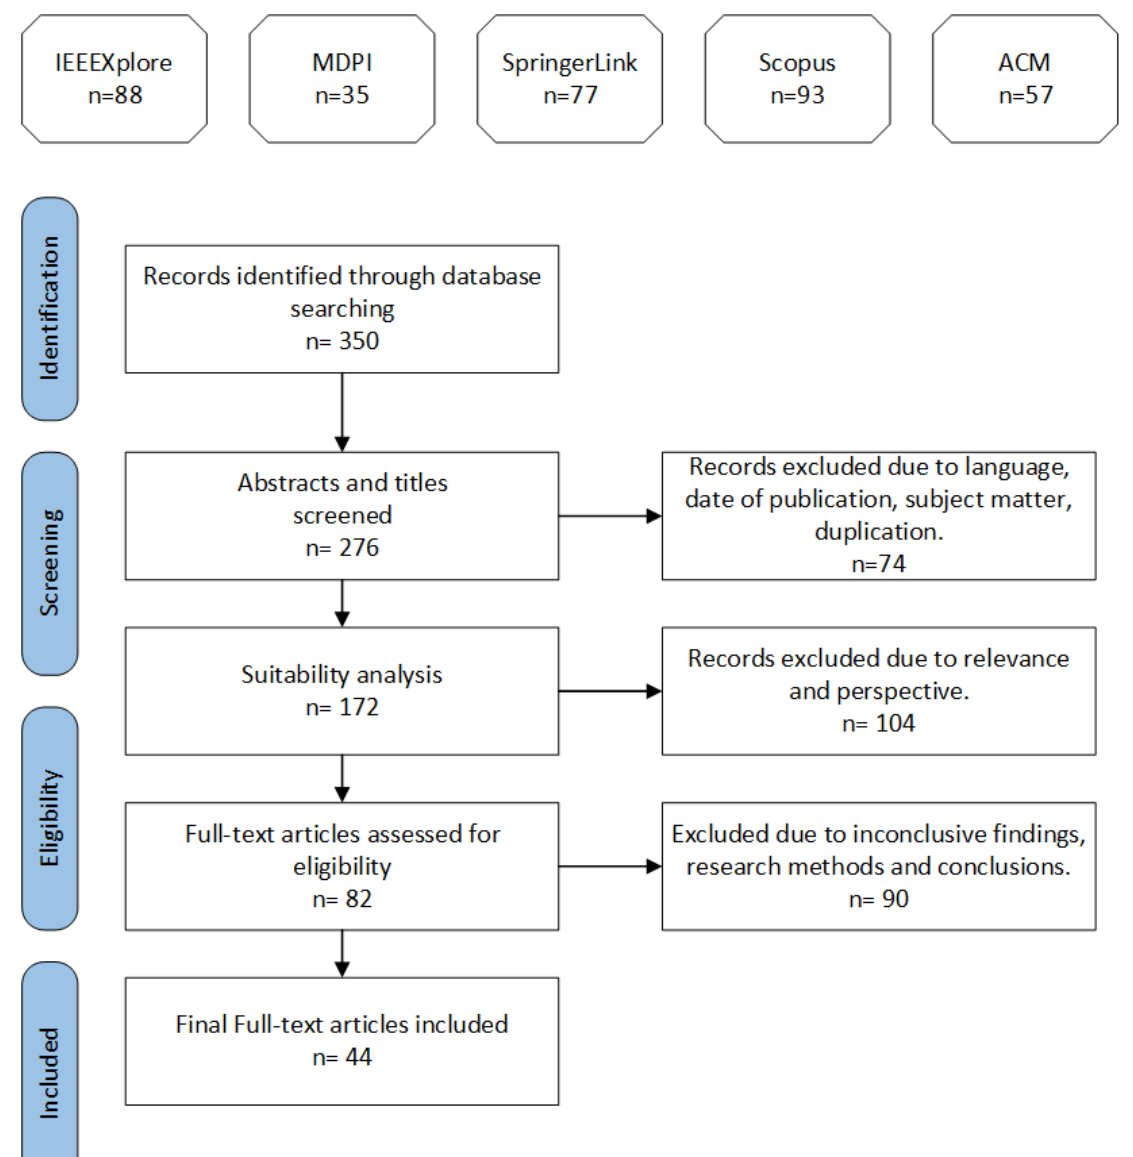
Figure 1. PRISMA flow